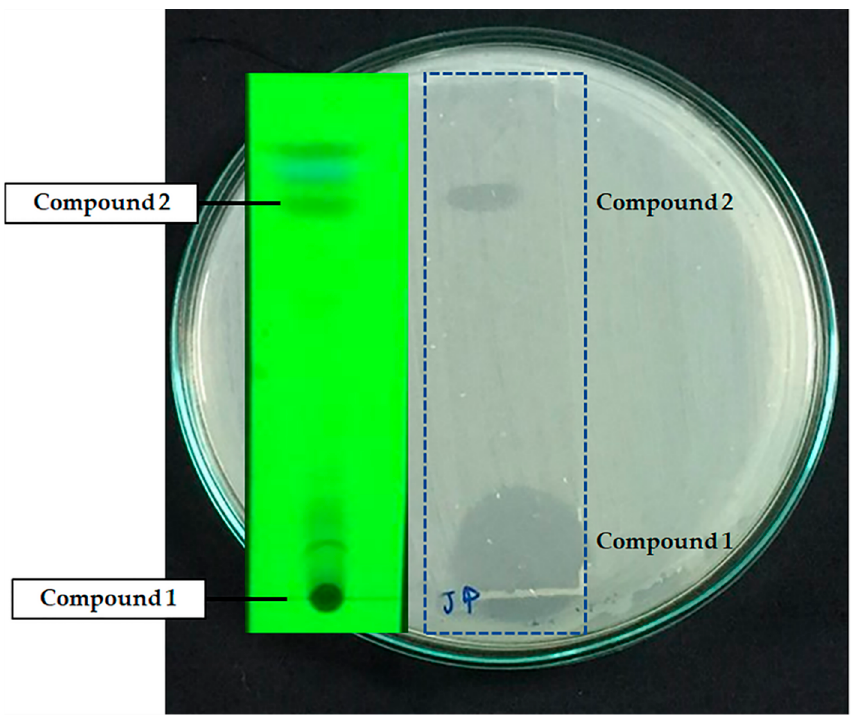
Figure 4. TLC-based bioautography of the ethyl acetate crude extract of PJ85 exhibiting antibacterial activity against MRSA DMST20651. activity against MRSA